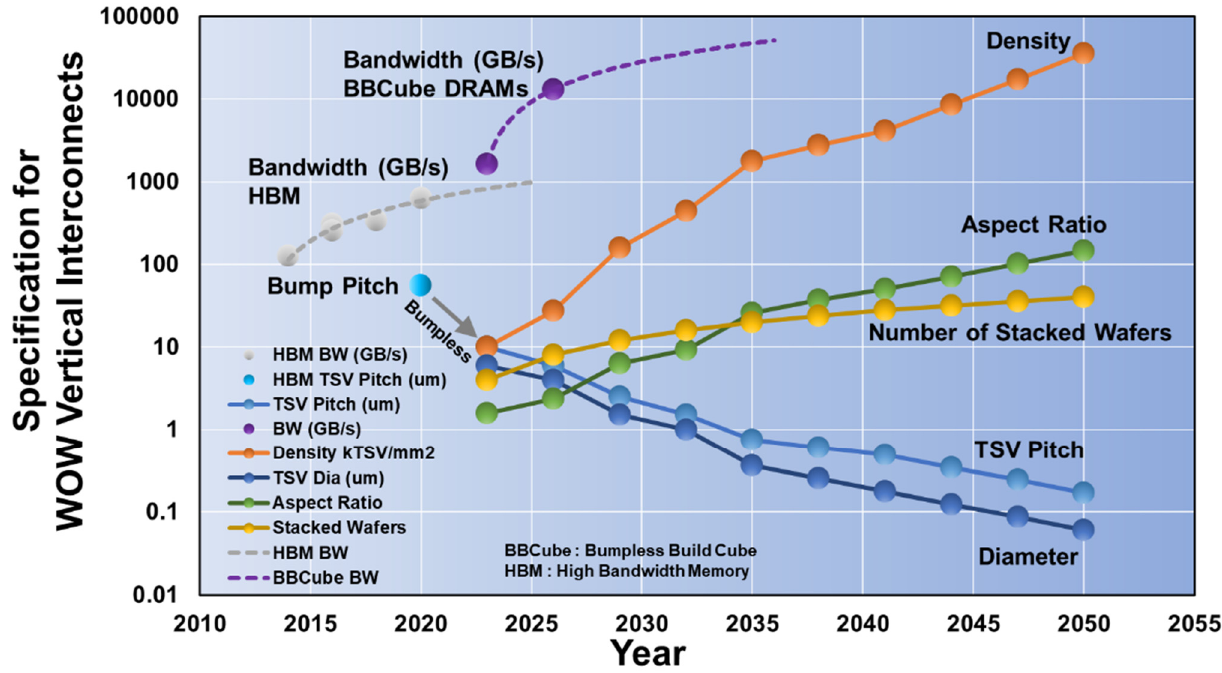
Figure 27. Trends of vertical interconnects of TSVs according to WOW Alliance.